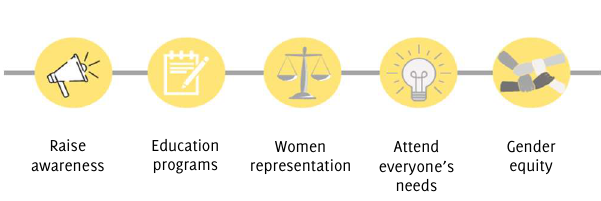
Figure 1 . Possible Solutions to Address Gender Bias and Stereotypes in